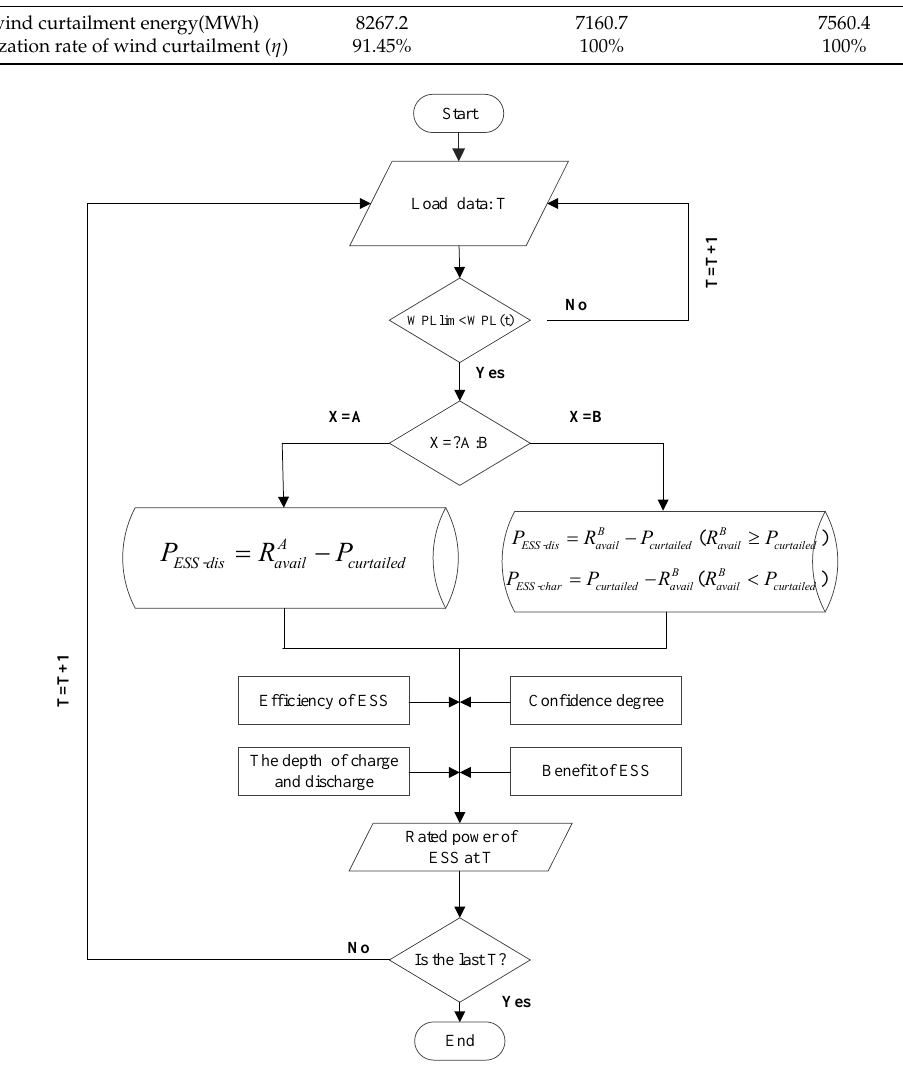
Figure 7. The configuration process of ESS’s capacity.